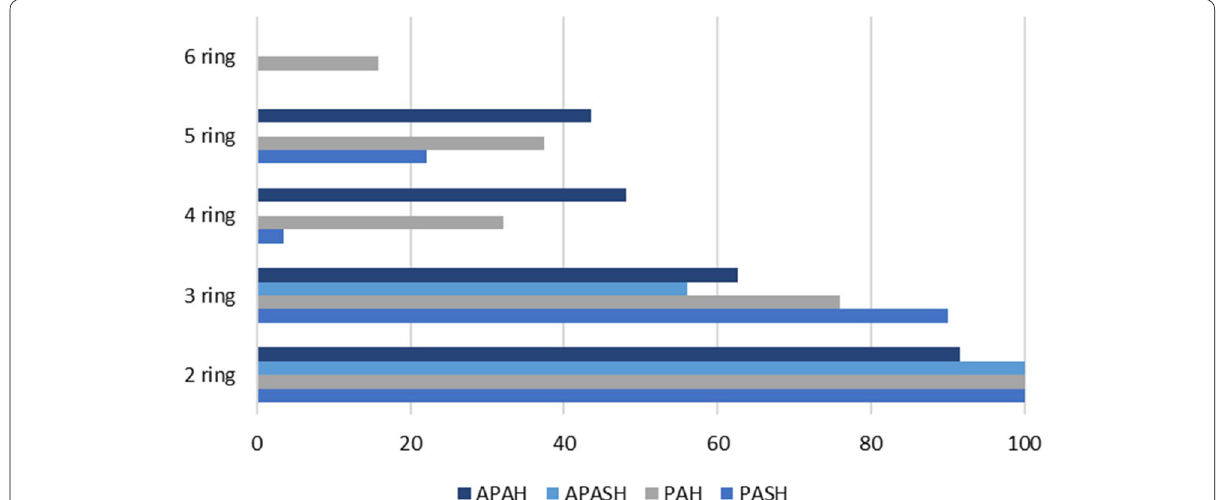
Fig. 5 Comparison of percent (%) losses between the un-weathered and weathered results in BK C